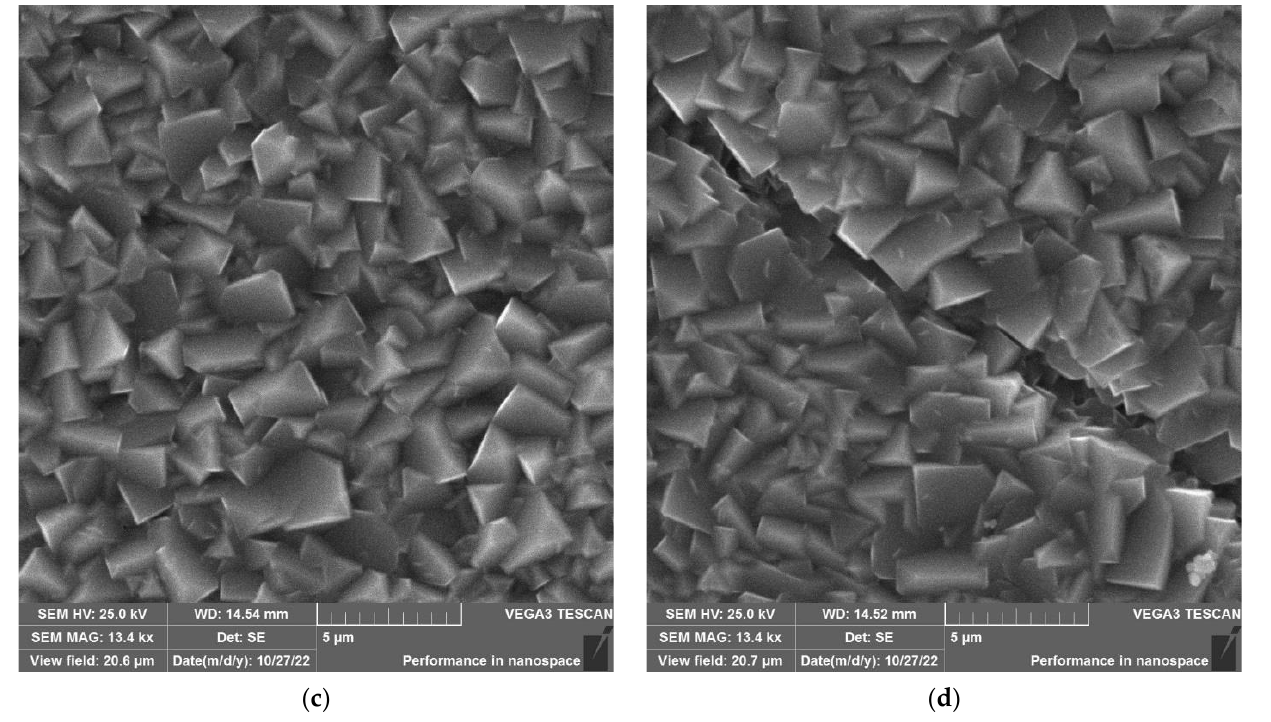
Figure 10. Surface of disk specimen № 9 (T irr = 550 °C, Table 4) at different magnifications after autoclave SCC tests with a load value of 801 N (before crack opening loading).